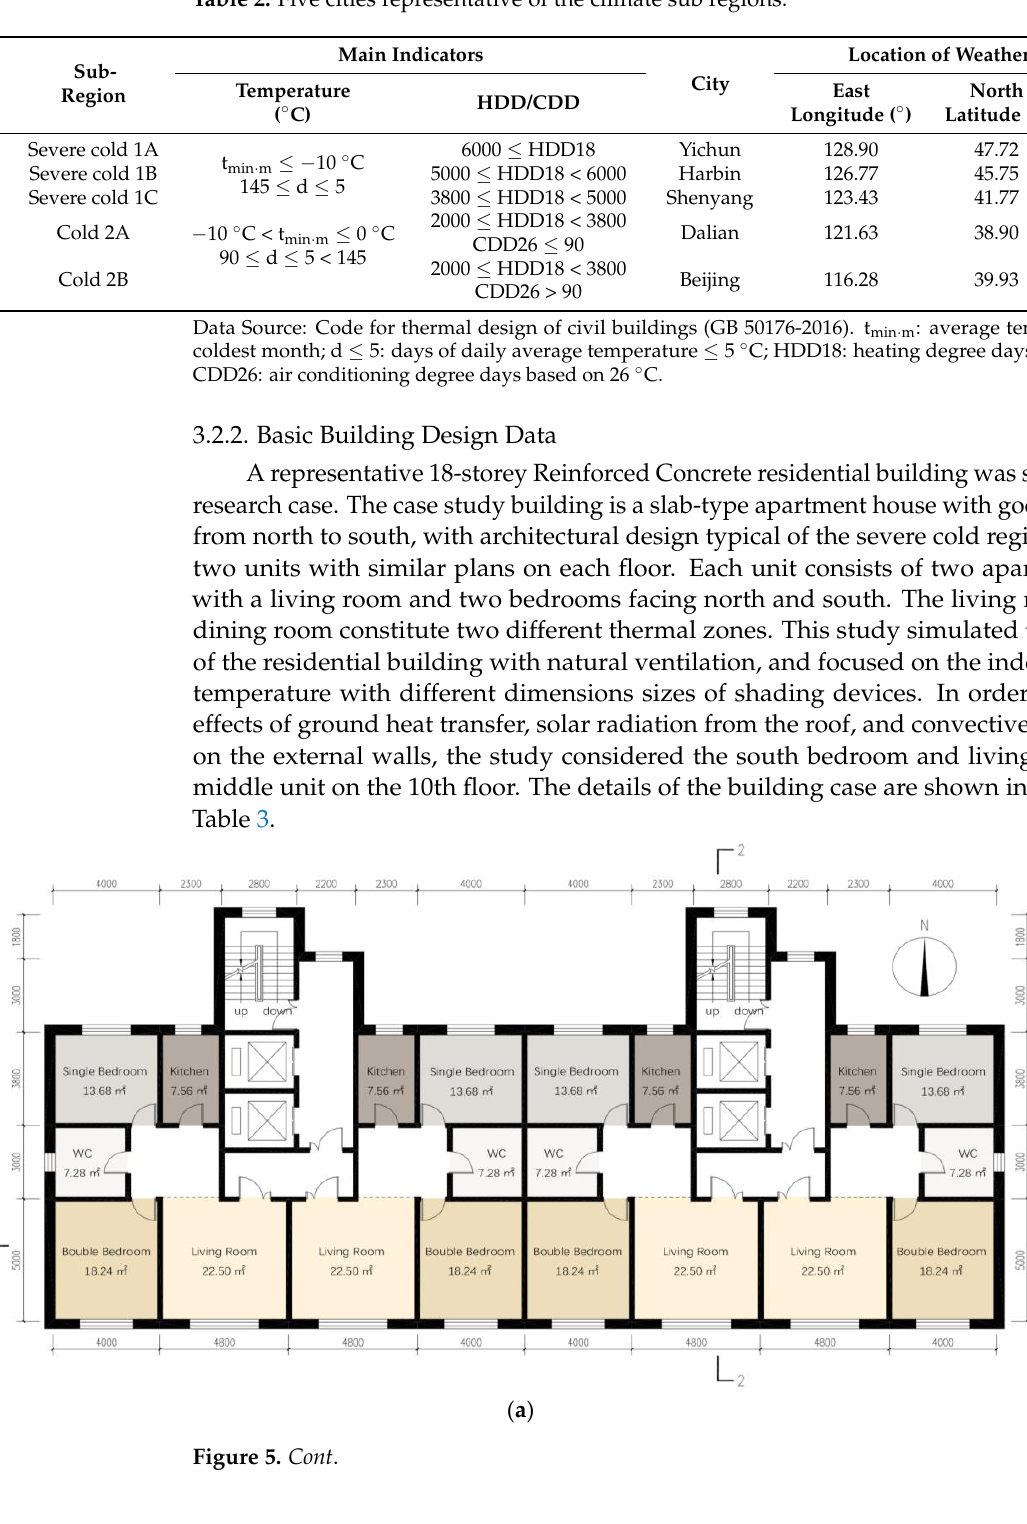
Table 2. Five cities representative of the climate sub